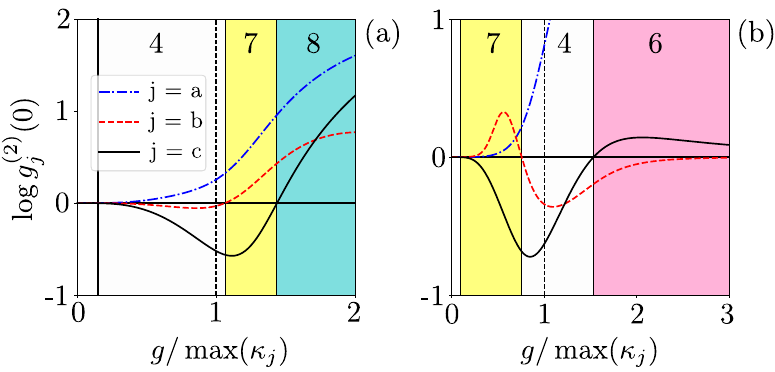
( 2 ) ( 0 ) (in the common logarithmic scale) versus the ratio of Figure 3. Second-order correlation functions g i qubit-SMR coupling strength and the largest decay rate. Different predictions of the sub- and super-Poissonian boson number statistics, which can be interpreted, respectively, as the PB and PIT effects, of the photonic (a), phononic (b), and hybrid (c) modes assuming: ( a ) the SMR-driven system with parameters specified in Eq. (28) and ( b ) the QD-driven system with Eq. (29). All the shown Cases (i.e., 4, 6, 7, and 8) correspond to those listed max κ j is the border line between the strong- and weak-coupling regimes. in Table 1. The broken line at g =